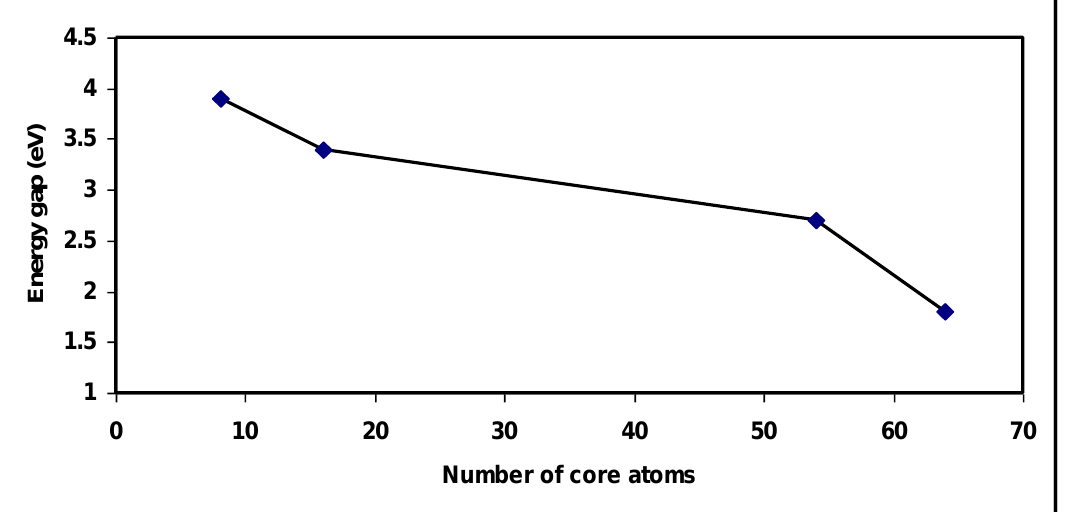
Fig. 5: Lattice constant variation with the number of core LUC atoms of CdS nanocrystals.